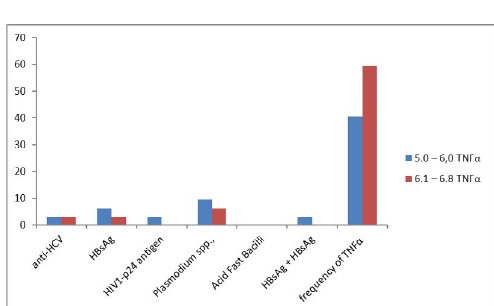
Fig. 3. Comparative analysis of anti-HCV, HBsAg, HIV1-p24 antigen, Acid Fast Bacilli and Plasmodium spp., in herbal home and hospital patients